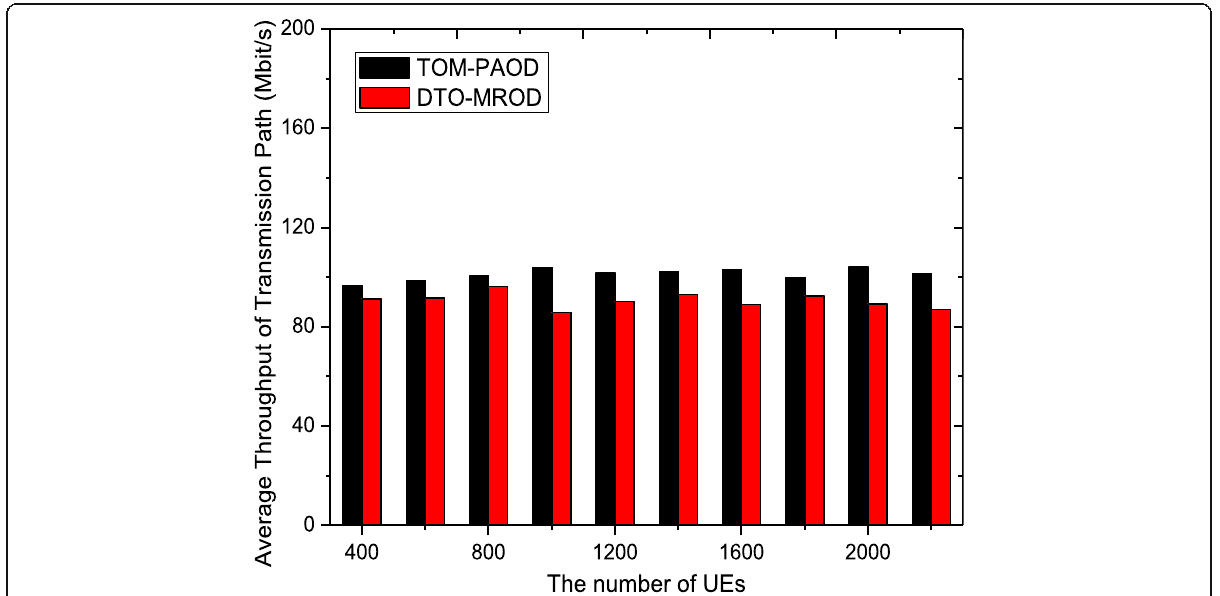
Fig. 3 Throughput performance comparison: variation trend of throughput in the two schemes with the number of UEs in the given region